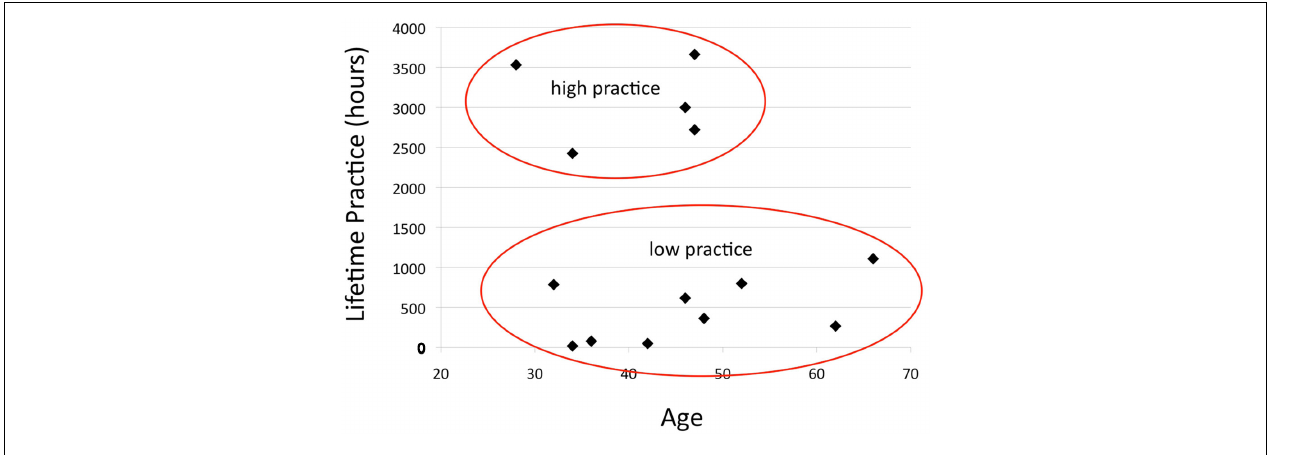
having > 2000h of experience (“high practice”) and nine participants having < 1200h (“low practice”).This difference was significant by t -test ( p < 0.001, see TableA1 ).